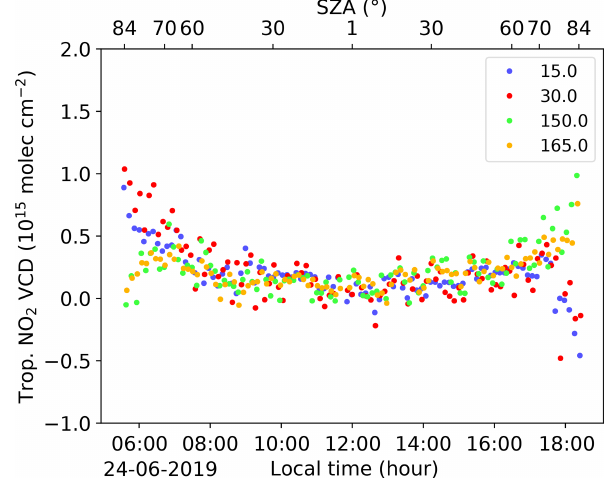
Figure 2. An example of diurnal cycle of stratospheric NO 2 VCDs on 5 February 2019. The NO 2 VCDs derived from different eleva- tion angles are indicated with different colours. The measurements were taken over the Pacific Ocean. At 12:00LT, RV Sonne was at 1.9 ◦ N, 140.9 ◦ W.